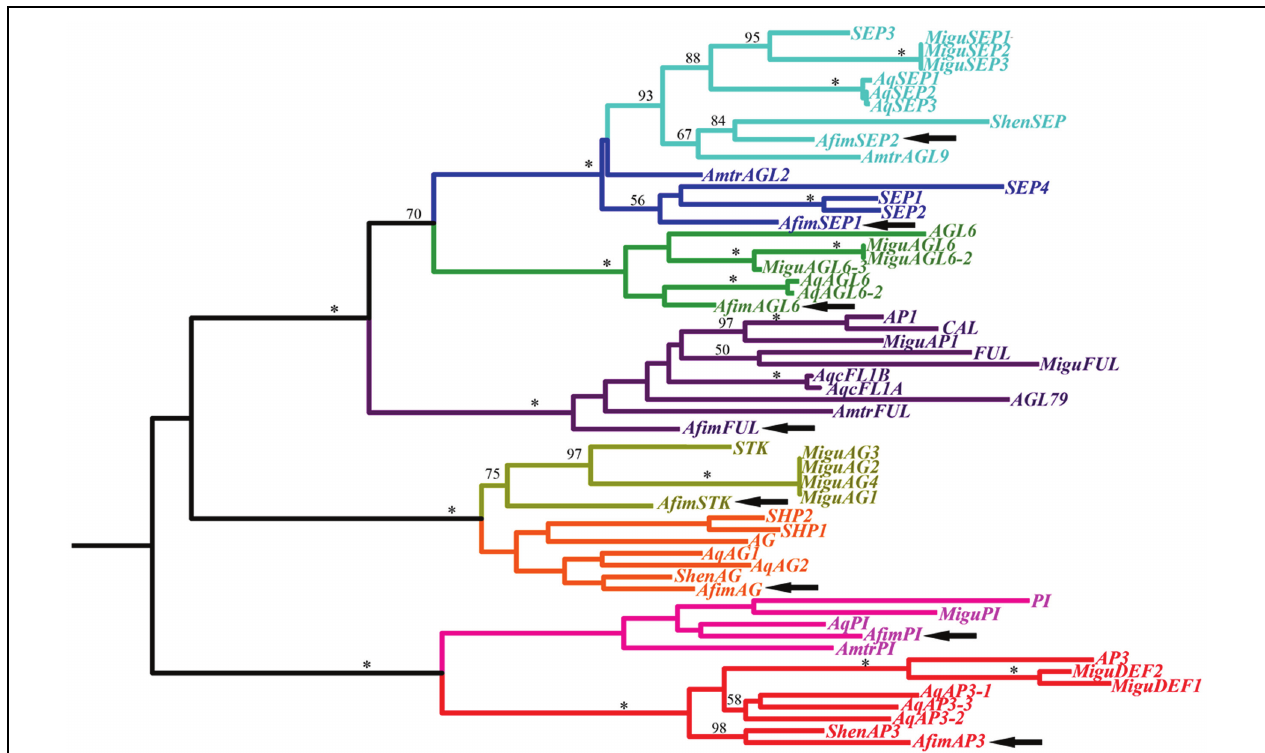
FIGURE 5 | Maximum likelihood tree of MADS-box genes identified in the transcriptome of A. fimbriata (arrows). Branch colors denote gene clades, as follows: blue, SEPALLATA ; green, AGAMOUS - Like 6; purple, APETALA1/FRUITFULL; ochre, SEEDSTICK ; orange, AGAMOUS / SHATTERPROOF; pink , PISTILLATA ; red, APETALA3 . BS values above 50% are placed at nodes. Asterisks indicate bootstrap (BS) of 100. Besides A . fimbriata , ingroup sequences include those of Amborella trichopoda (Amborellaceae), Saruma henryi (Aristolochiaceae), Aquilegia coerulea (Ranunculaceae), Mimulus guttatus (Phrymaceae), and Arabidopsis thaliana (Brassicaceae), representing the ANA grade, the magnoliids, the basal eudicots, the asterids and the rosids,